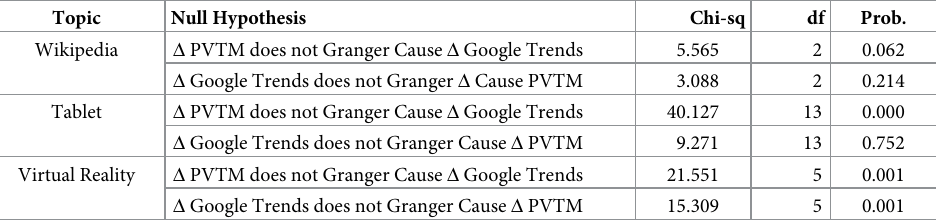
Table 1. VAR Granger causality/block exogeneity wald